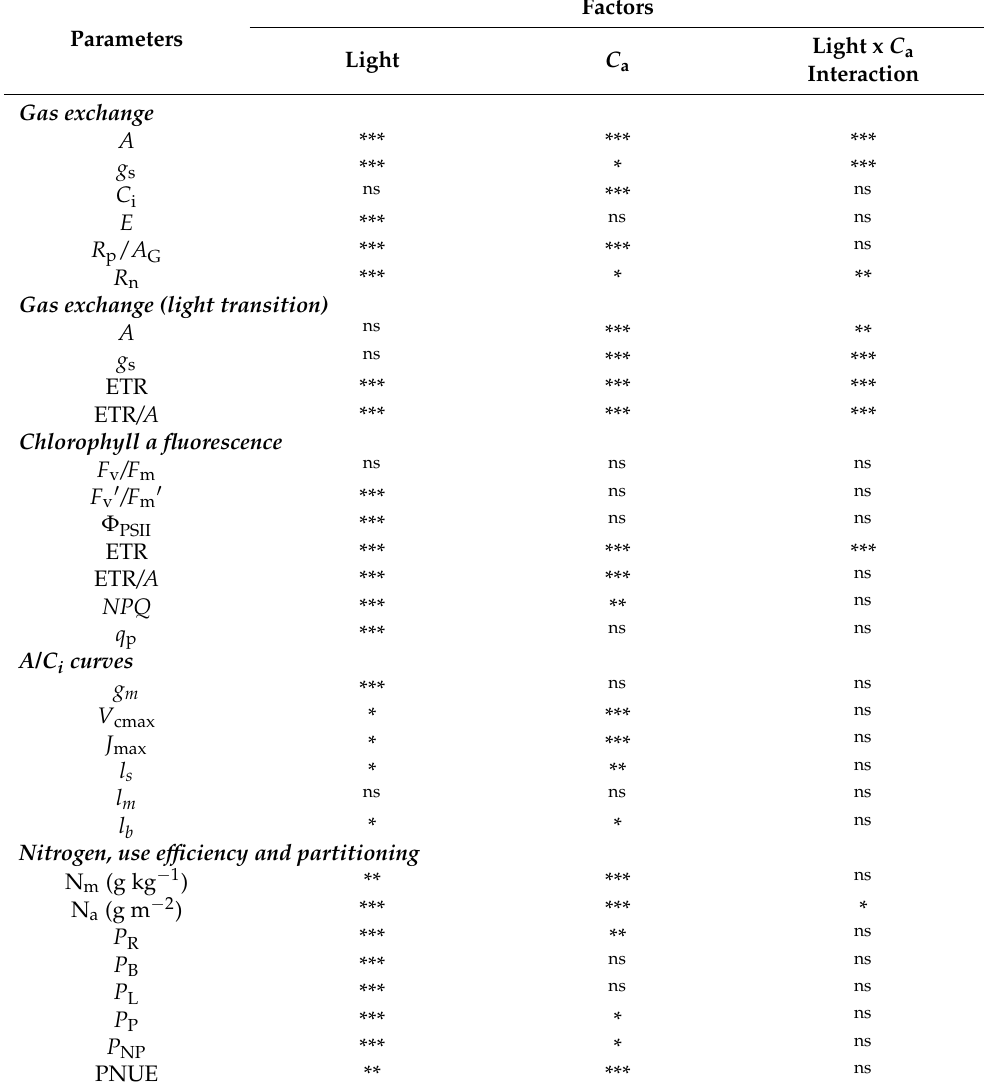
Table A1. The proportion of explained variance by light and atmospheric [CO 2 ] ( C a ) factors and by the interaction between these factors (two-way ANOVA) of morphological, physiological, and biochemical traits of coffee plants grown under changing light and C a supplies ( F test: ns ,